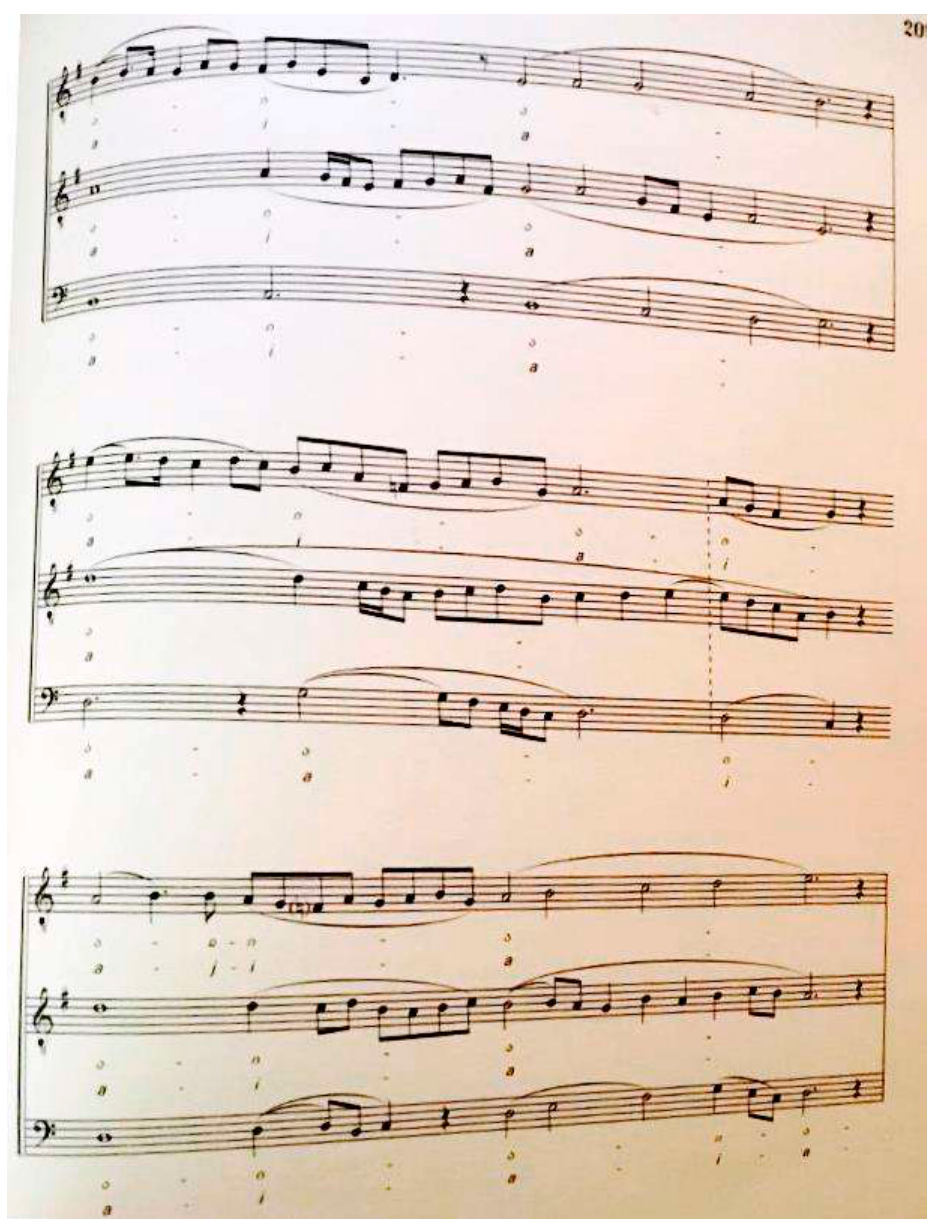
Figure 18. Holy, Holy, Holy; Shemokmedi School (Shugliashvili et al. 2014).